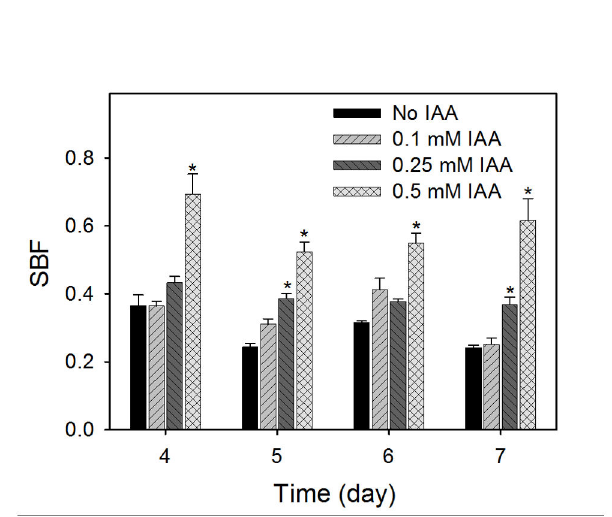
Figure 6. Effects of different concentrations of IAA on SBF by B. japonicum in minimal medium. The amount of biofilm was determined by the crystal violet staining method and calculated as follows: SBF = (B-C)/G, where B is the OD of 595 the attached biofilm cells, C is the OD of the stained control 595 wells containing the medium only, and G is the OD of cells 600 grown in broth. Values are means ± standard errors of the means for three independent experiments with three replications each. An asterisk (*) indicates a significant difference between the treatment and the control (no IAA), with a P < 0.05 using Student’s